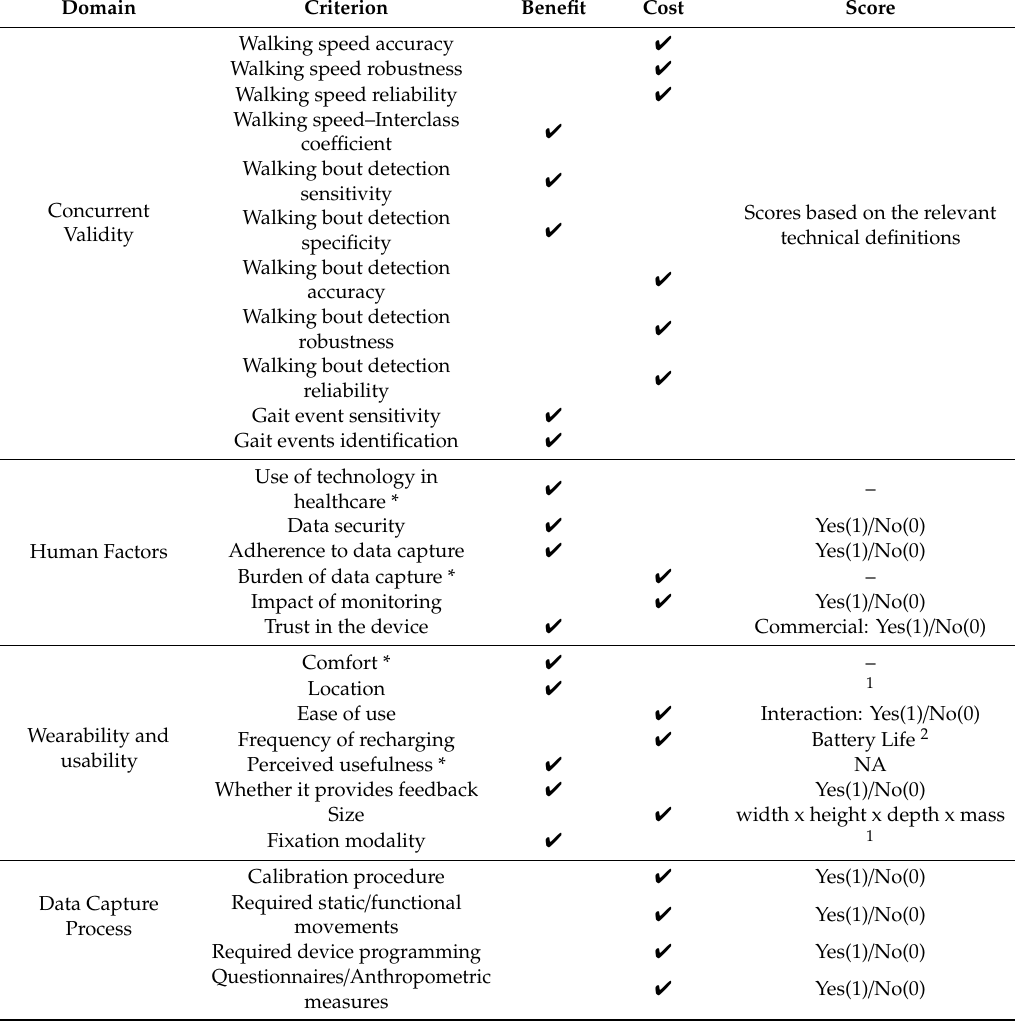
Table 1. Cost / benefit criteria and scoring